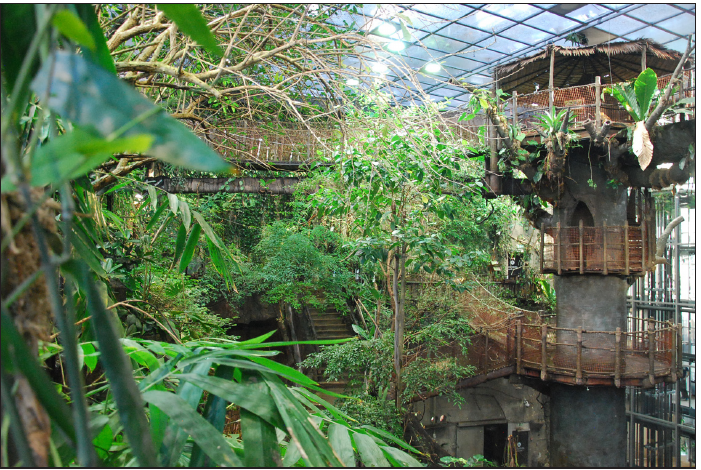
Figure 1: The Kapok tree. The tree made out of concrete was a powerful image, a wow- experience, when it appeared in front of the visitors. Universeum 2016. (Photo: Lars